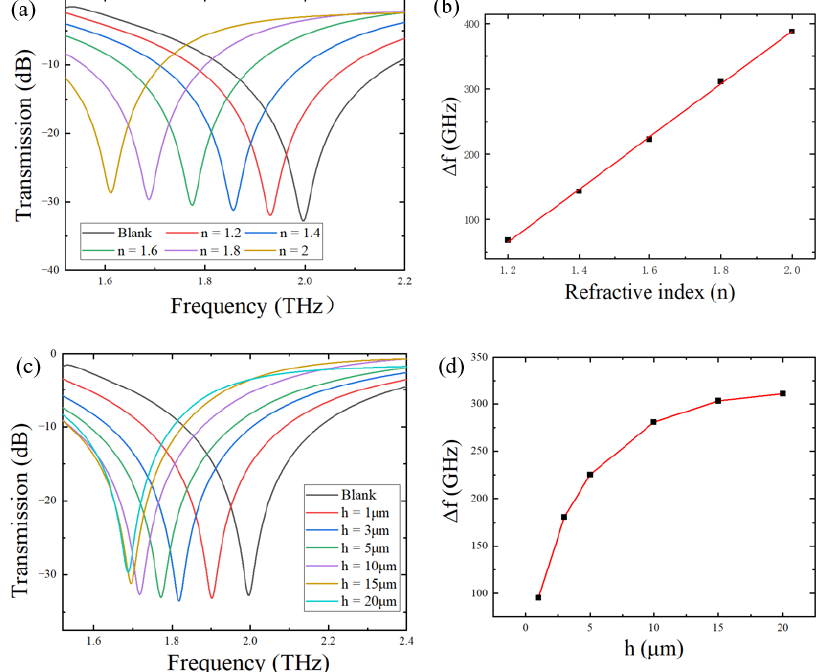
Figure 4. ( a ) Transmission spectra of the simulated metamaterial sensor covered by analytes with different refractive indices at h = 20 μ m; ( b ) variation in the resonant peak frequency shift with the refractive index of the analyte; ( c ) transmission spectra of the simulated metamaterial sensor covered by analytes with different thicknesses at n = 1.8; ( d ) variation in the resonant peak frequency shift with the thickness of the analyte.